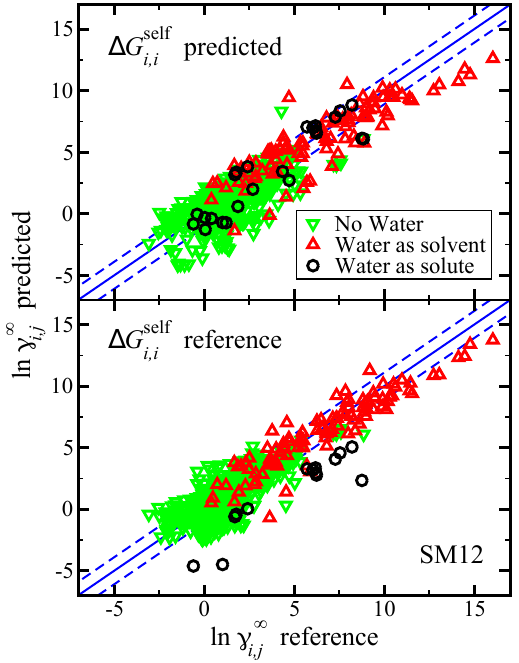
Figure 5. Parity plot of the predicted versus reference values of ln γ ∞ using the SM12 universal solvent i , j model for the case where water was the solvent, water was the solute, and where water was neither the solvent or solute, as indicated. The blue lines corresponds to the y = x line, and the dashed blue lines correspond to ± 1.1 and are drawn as a reference; the value of 1.1 was used based on the RMSE for the SM12 predictions. The reference values are from the Minnesota Solvation Database. In the top pane we present results when ∆ G self was predicted using the SM12 universal solvent model. In the bottom pane i , i we present results when ∆ G self was computed using reference vapor pressure i , i